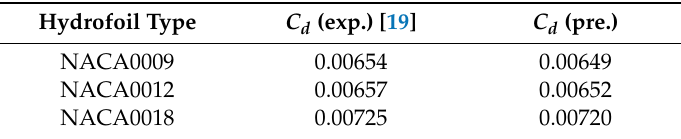
Table 8. Results obtained after changing the thickness of the hydrofoil ( Re = 3.4 × 10 −6 ).